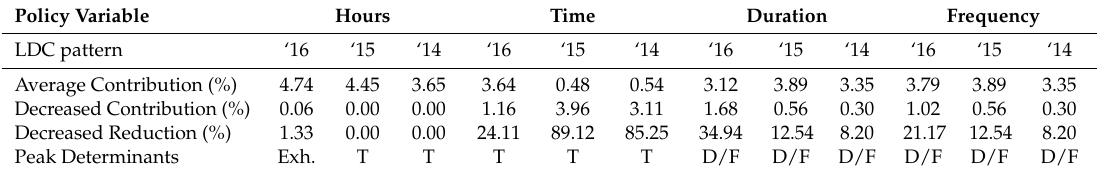
Table 6. Summary of initial sensitivity simulation results with strengthened constraints.